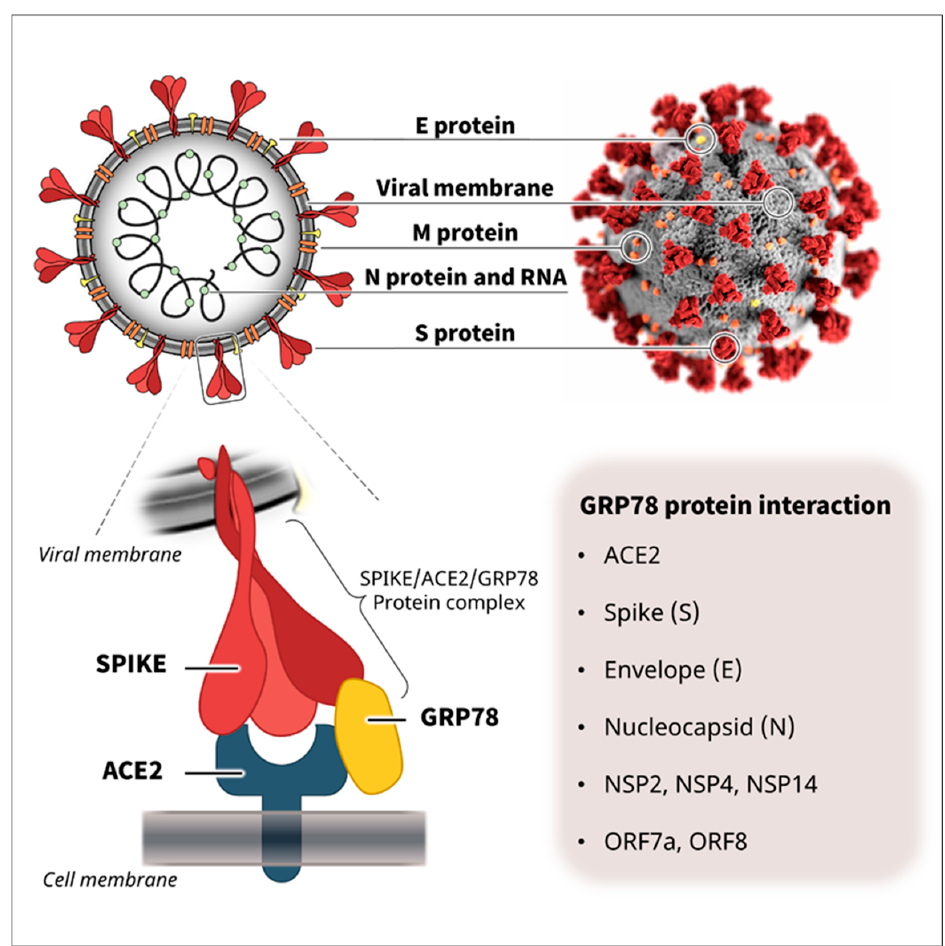
Figure 1. SARS-CoV-2 structure and protein interactions. SARS-CoV-2 is enveloped by a lipid bilayer membrane and consists of several viral proteins [24–26]. Recently, we and another research group independently reported that GRP78 functions as a host co-receptor for SARS-CoV-2 infection via complex formation with SARS-CoV-2 spike protein and host receptor ACE2 [12,15]. Cumulative protein interactome data have shown that GRP78 can also interact with other viral proteins of SARS-CoV-2, such as the spike (S), envelope (E), nucleocapsid (N), NSP2, NSP4, NSP14, ORF7a, and ORF8 [16], suggesting its possible involvement in other lifecycle stages and pathology of SARS-CoV-2. The upper right illustration of SARS-CoV-2 was created at the Centers for Disease Control and Prevention